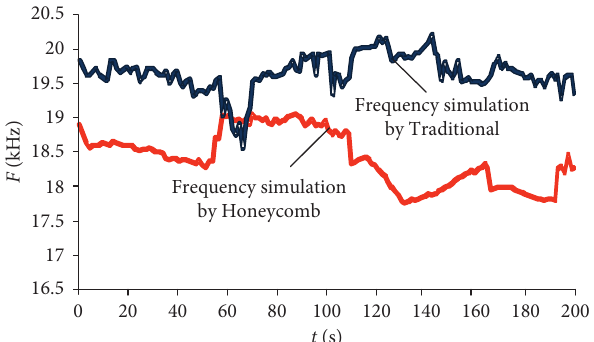
Figure 7: Frequency comparison of simulation in different ul- trasonic vibration